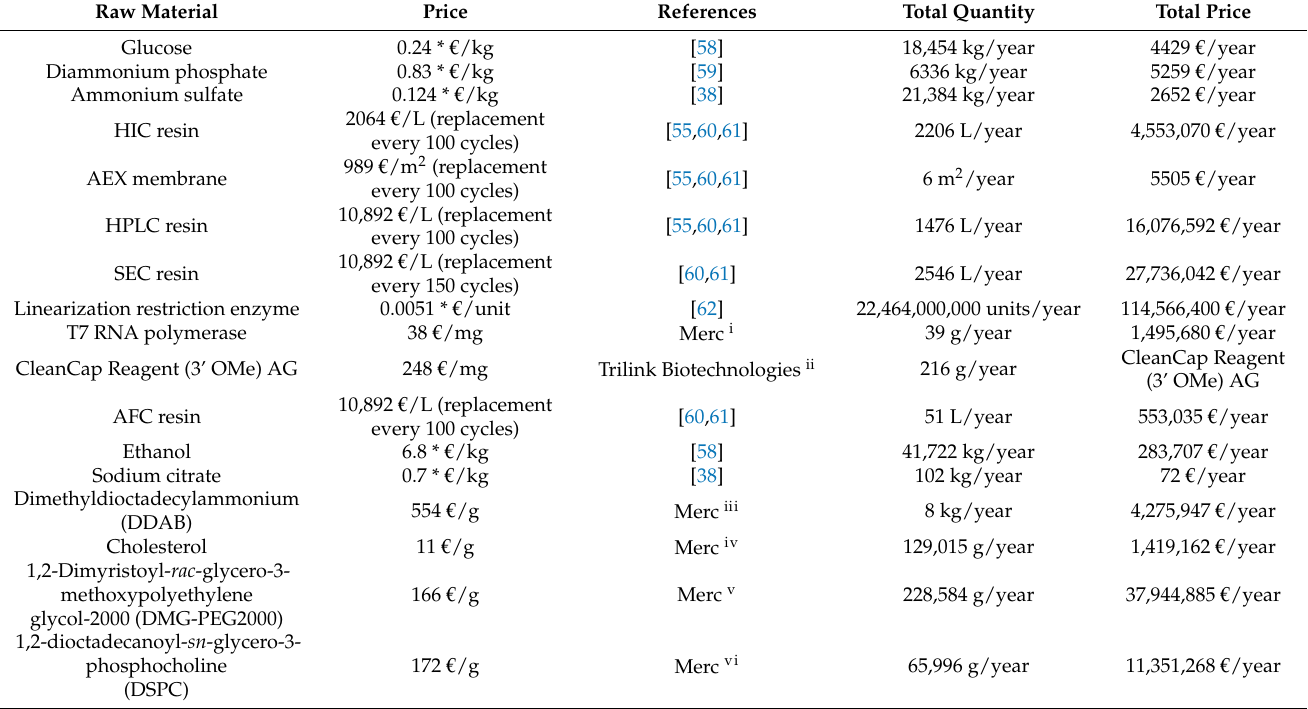
Table 9. Raw material quantification and